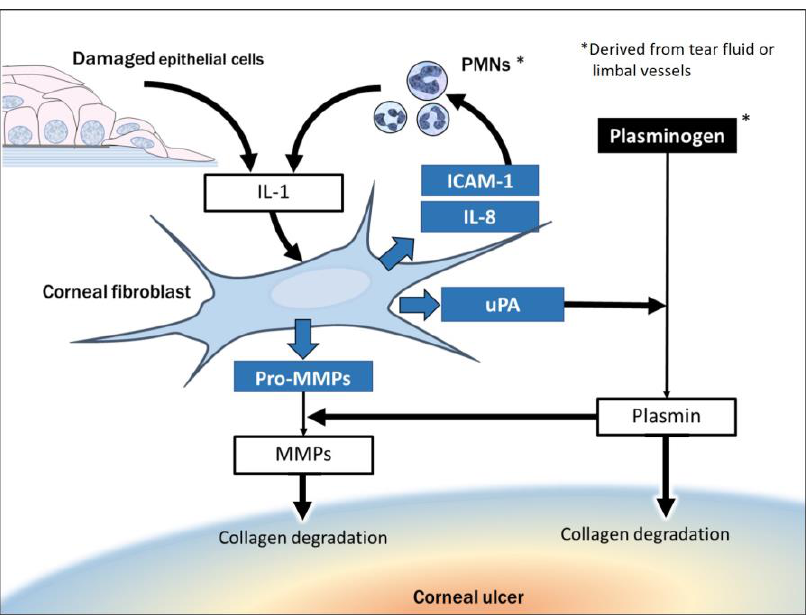
Figure 1. Pathway of collagen degradation mediated by corneal fibroblasts. IL, interleukin; PMN, polymorphonuclear neutrophil; ICAM-1: intercellular adhesion molecule-1; uPA: urokinase-type plasminogen activator; MMP: matrix metalloproteinase.